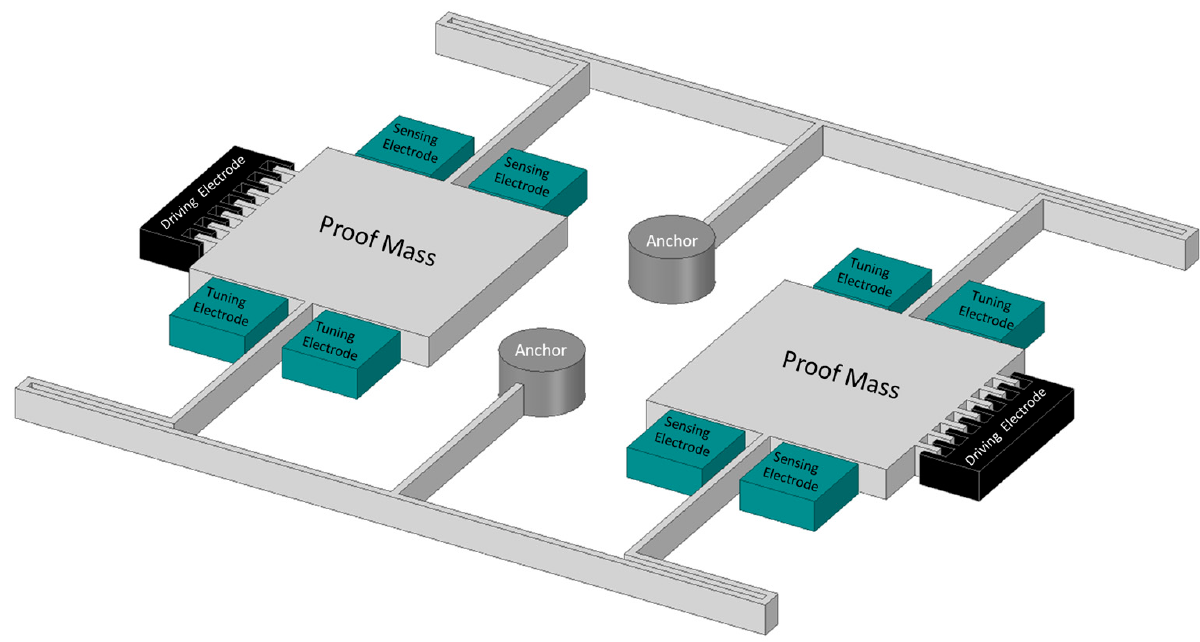
Figure 10. Schematic diagram of high Q MEMS tuning fork gyroscope.